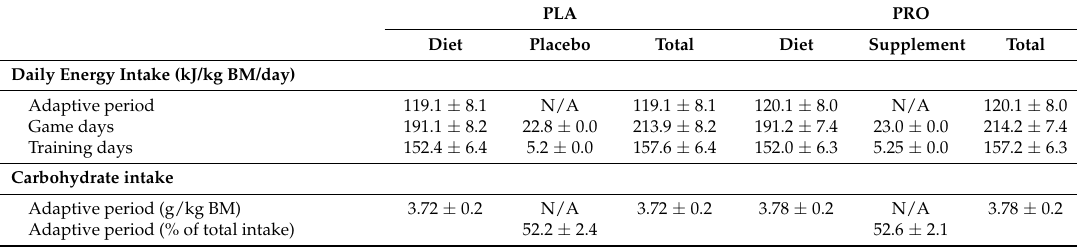
Table 2. Participants’ dietary energy intake and antioxidant profiles during the study. PLA PRO Diet Placebo